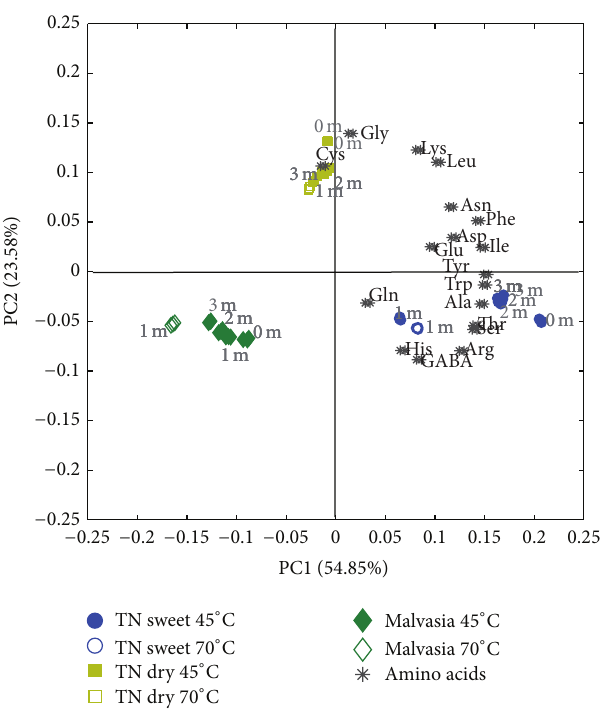
Figure 3: PC2 versus PC3 biplot of the Madeira wine’s sample set in study, in order to reveal how wines evolve during the estufagem at standard (45 ∘ C) and overheating (70 ∘ C)